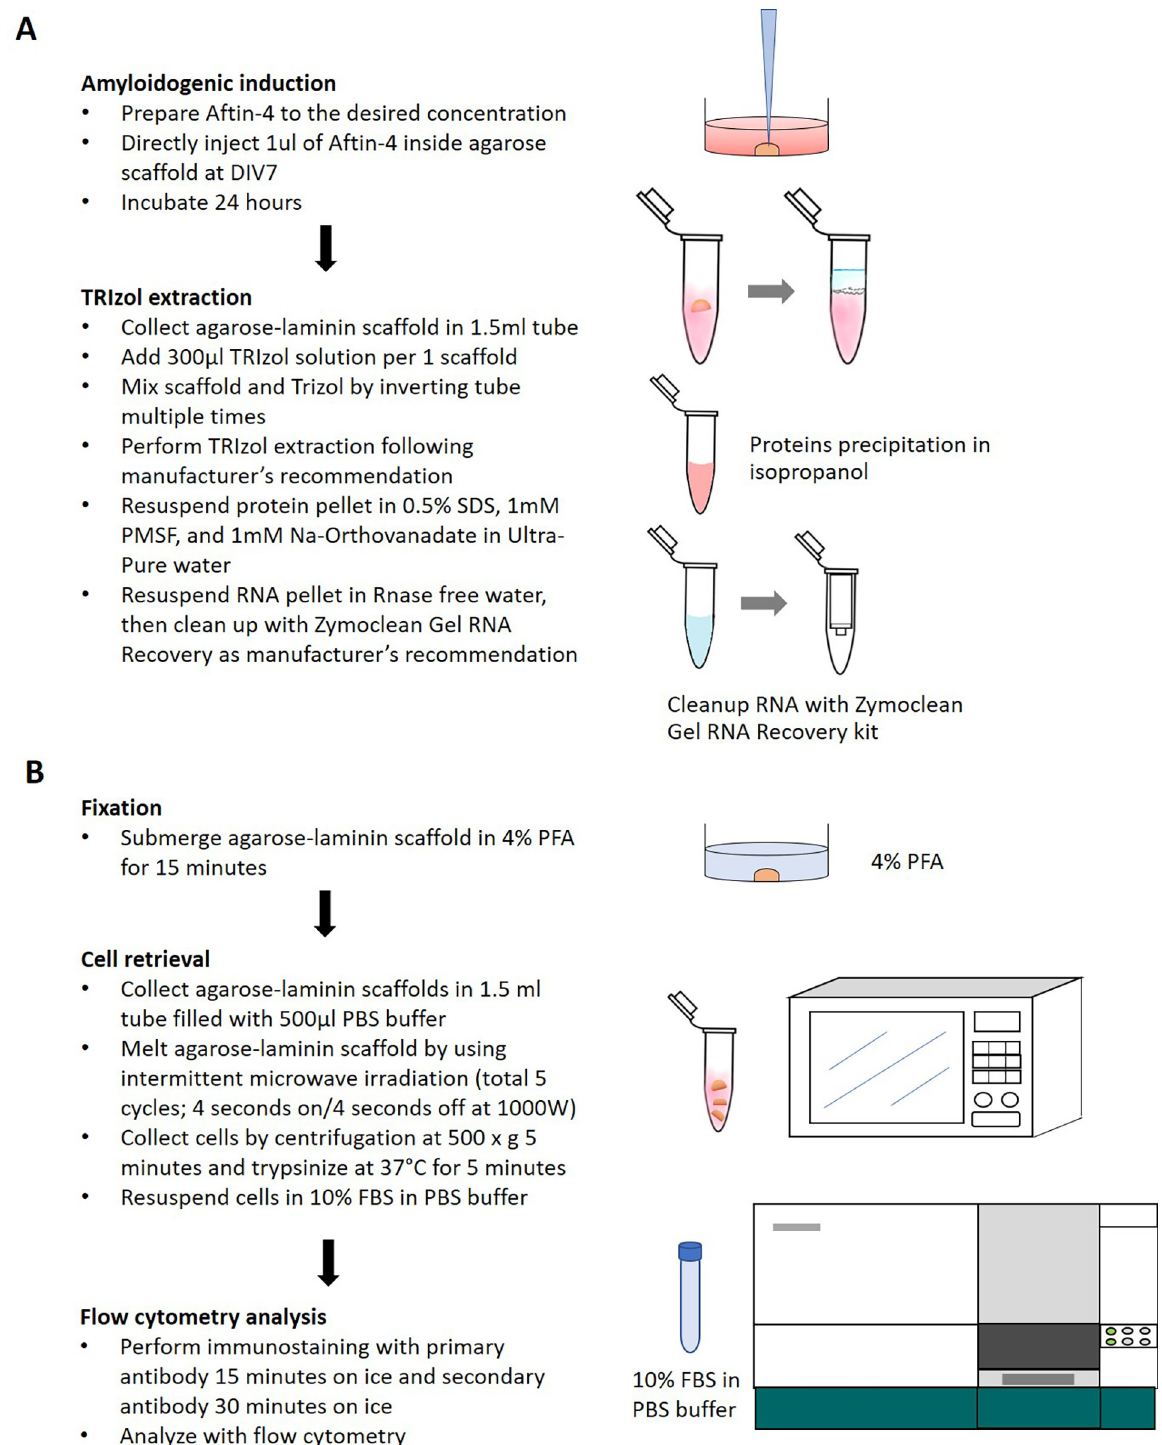
Fig 2. An amyloidogenic induction in vitro A) A workflow diagram of the amyloidogenic induction in cell-laden agarose-laminin scaffold. B) A workflow diagram of the cell retrieval from cell-laden agarose-laminin scaffold.